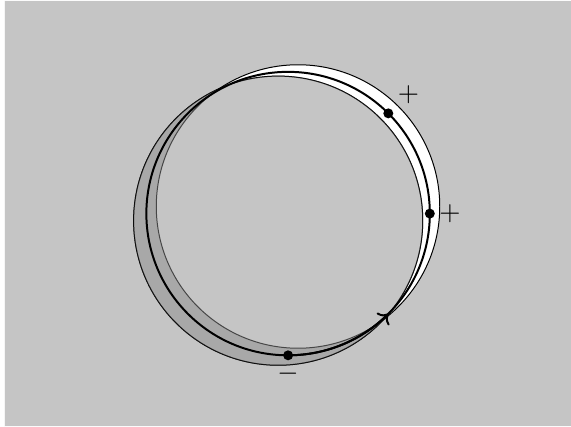
Figure 3 . A geometric route to the in-out-in-out ordering and celestial circle support of allowed 2 → 2 scattering processes. After placing punctures with ( (cid:15) 1 , (cid:15) 2 , (cid:15) 3 ) = (+ , + , − ) , the additional − puncture cannot be placed in any of the grey regions by theorem 2. Translating and dilating the circles leaves the only allowed position on the arc between the two +